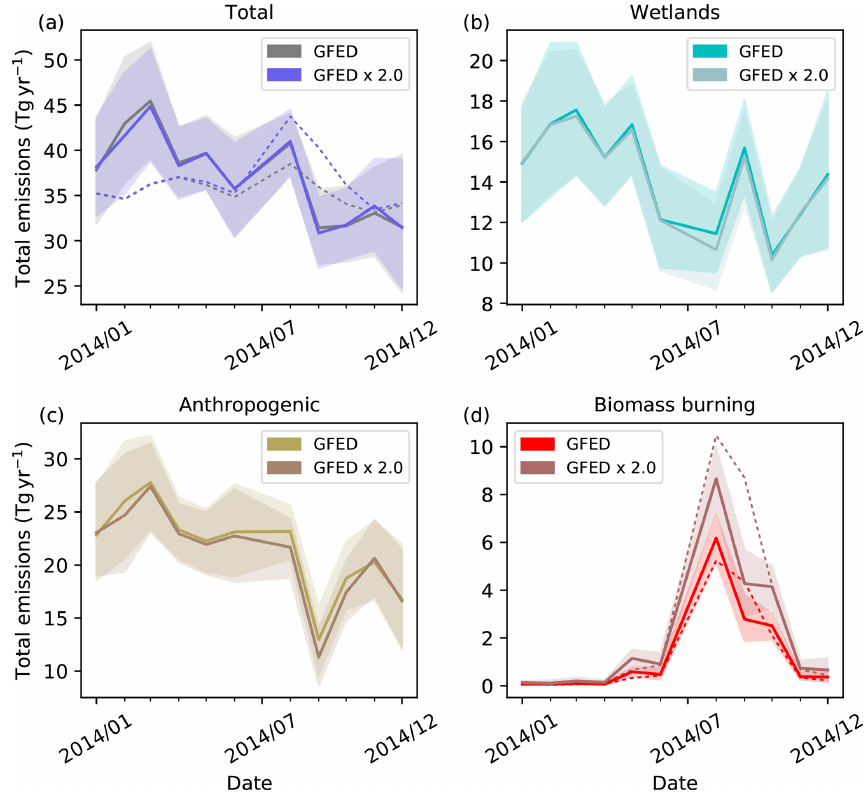
Figure A8. Brazil’s CH 4 emissions in a sensitivity inversion using perturbed a priori biomass burning emissions. All other components were held at the original configuration. Biomass burning emissions for all of South America were doubled from GFED. (a) Total, (b) wetland, (c) anthropogenic and (d) biomass burning emissions. Prior emissions are only shown in (a, d) as they only vary for these components in this